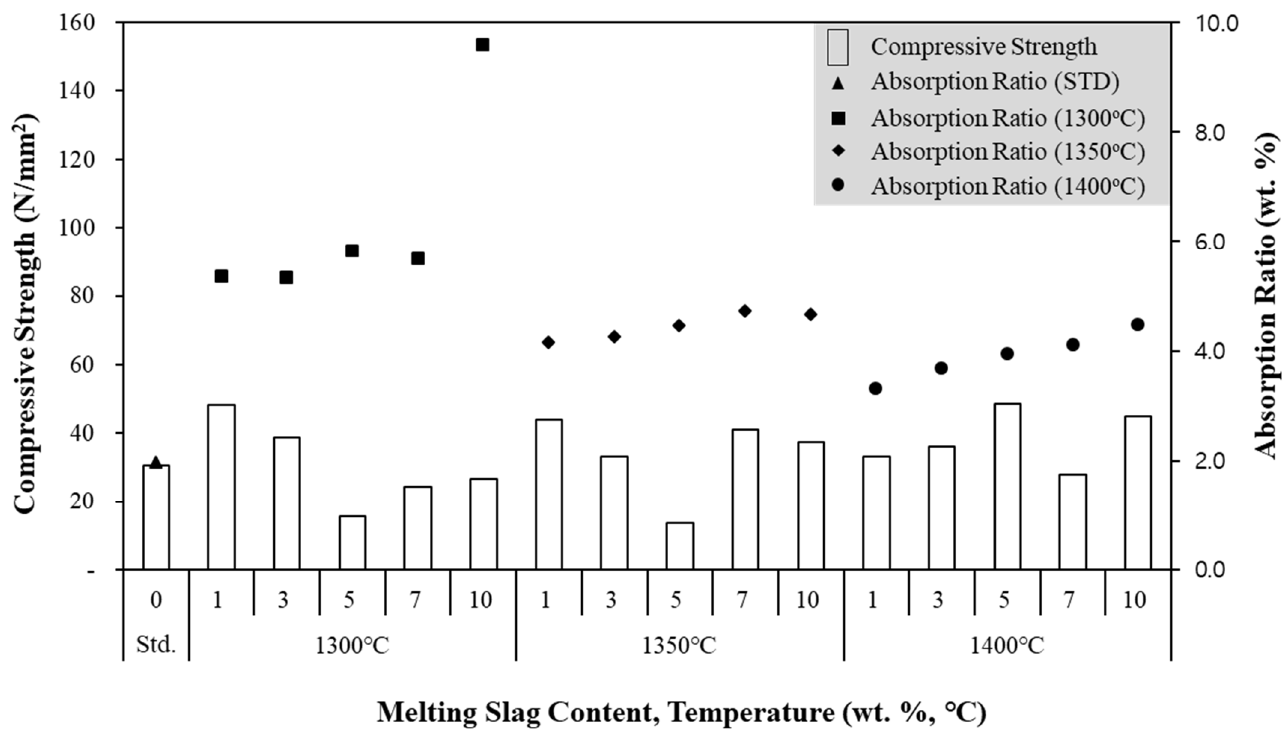
Figure 7. Compressive Strength Results of Clay Bricks for Different Conditions.